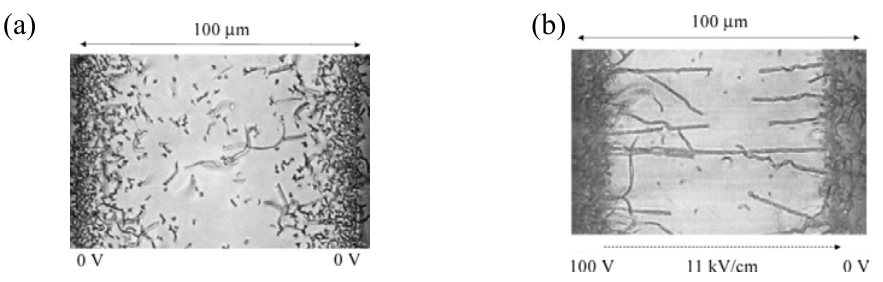
Figure 27. Optical microscopy images of (a) TTF • TCNQ grains formed by the co-evaporation technique with zero electric field at 42 °C and of (b) TTF • TCN Q wires grown at 42 °C under high electric field of 11 kV/cm (110 V). The electrode gap is 100 μ m. Japanese Society of Applied